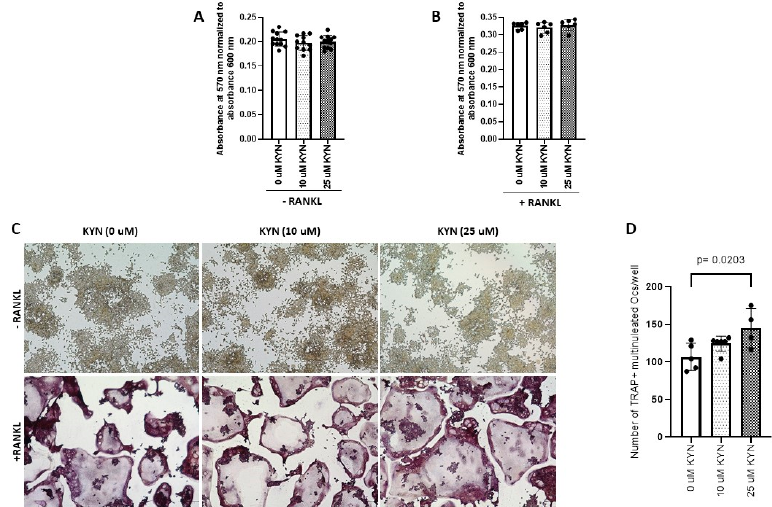
Figure 1. Kynurenine (KYN) treatment induces RANKL-mediated osteoclast differentiation of Raw 264.7. KYN treatment (10 µ M or 25 µ M) for 48 h does not a ff ect viability of Raw 264.7 cells either